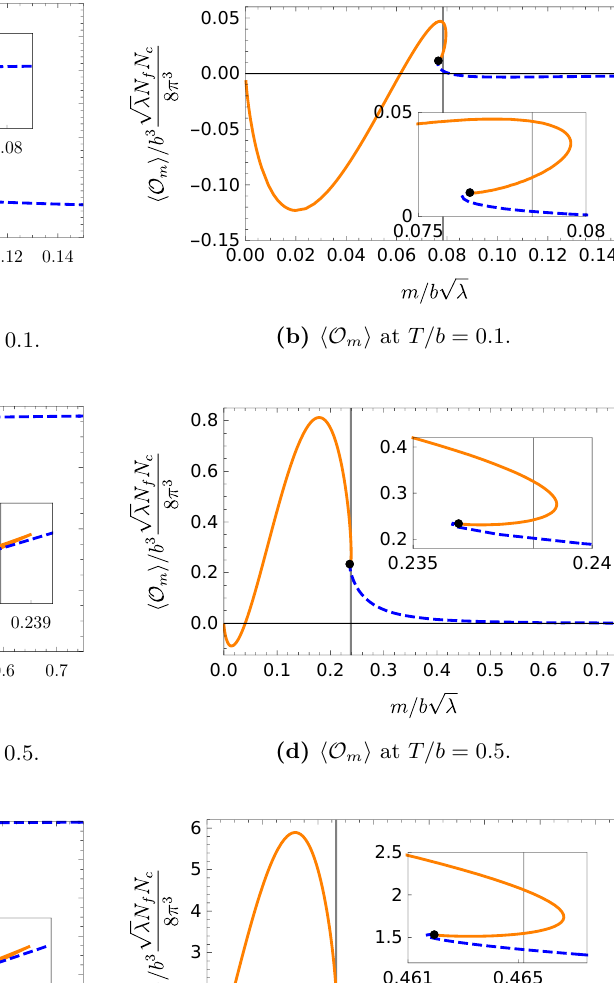
Figure 3. Our numerical results for the free energy density f/ ( b 4 λN f N c √ λ ) , for (a) and (b) T/b = 0 . 1 , (c) and (d) T/b = 0 . 5 , and (e) , and (f) as functions of m/ ( b T/b = 1 . As in figures 1 and 2, the solid orange and dashed blue lines correspond to black hole and Minkowski embeddings, respectively, and the black dots denote critical embeddings. The insets are close-ups near critical embeddings, showing f ’s “swallow tail” and hO m i ’s spiral, both characteristic of first-order transitions. The vertical gray lines indicate the values of m/ ( b the first-order